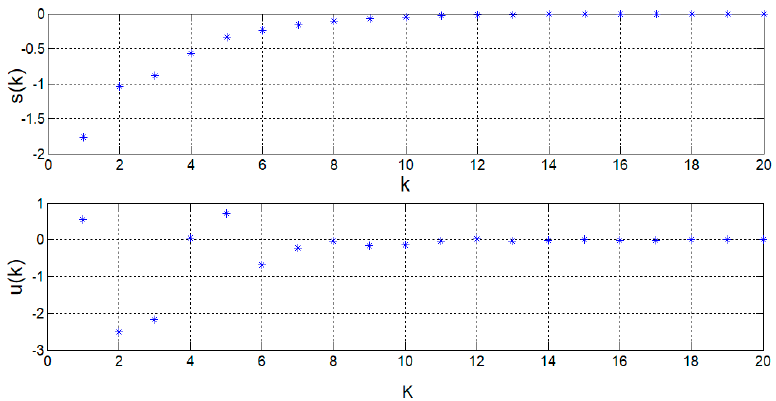
Figure 4. Time responses of the switching surface ( s ( k )) and controller ( u ( k )).